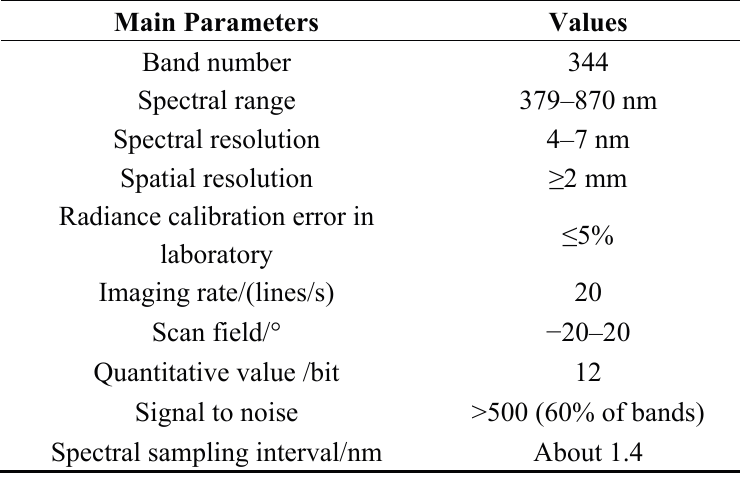
Table 1. Main parameters and specifications of the FISS.